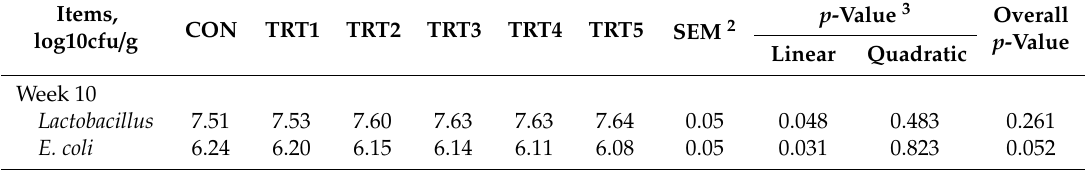
Table 4. The e ff ect of black pepper supplementation on the fecal microbial of finishing pigs 1 . Items,